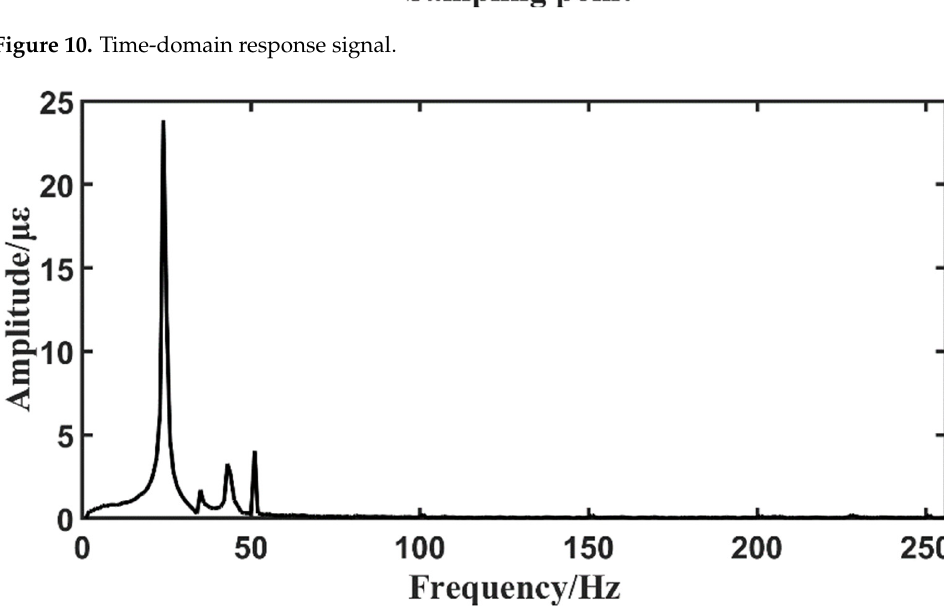
Figure 11. Frequency-domain response signal.